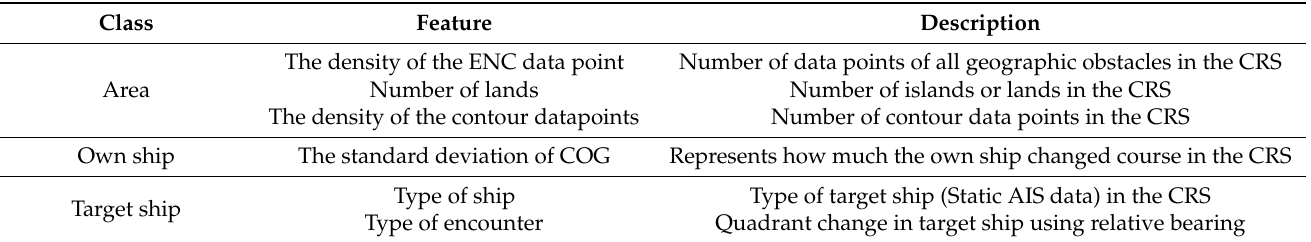
Table 6. List of selected